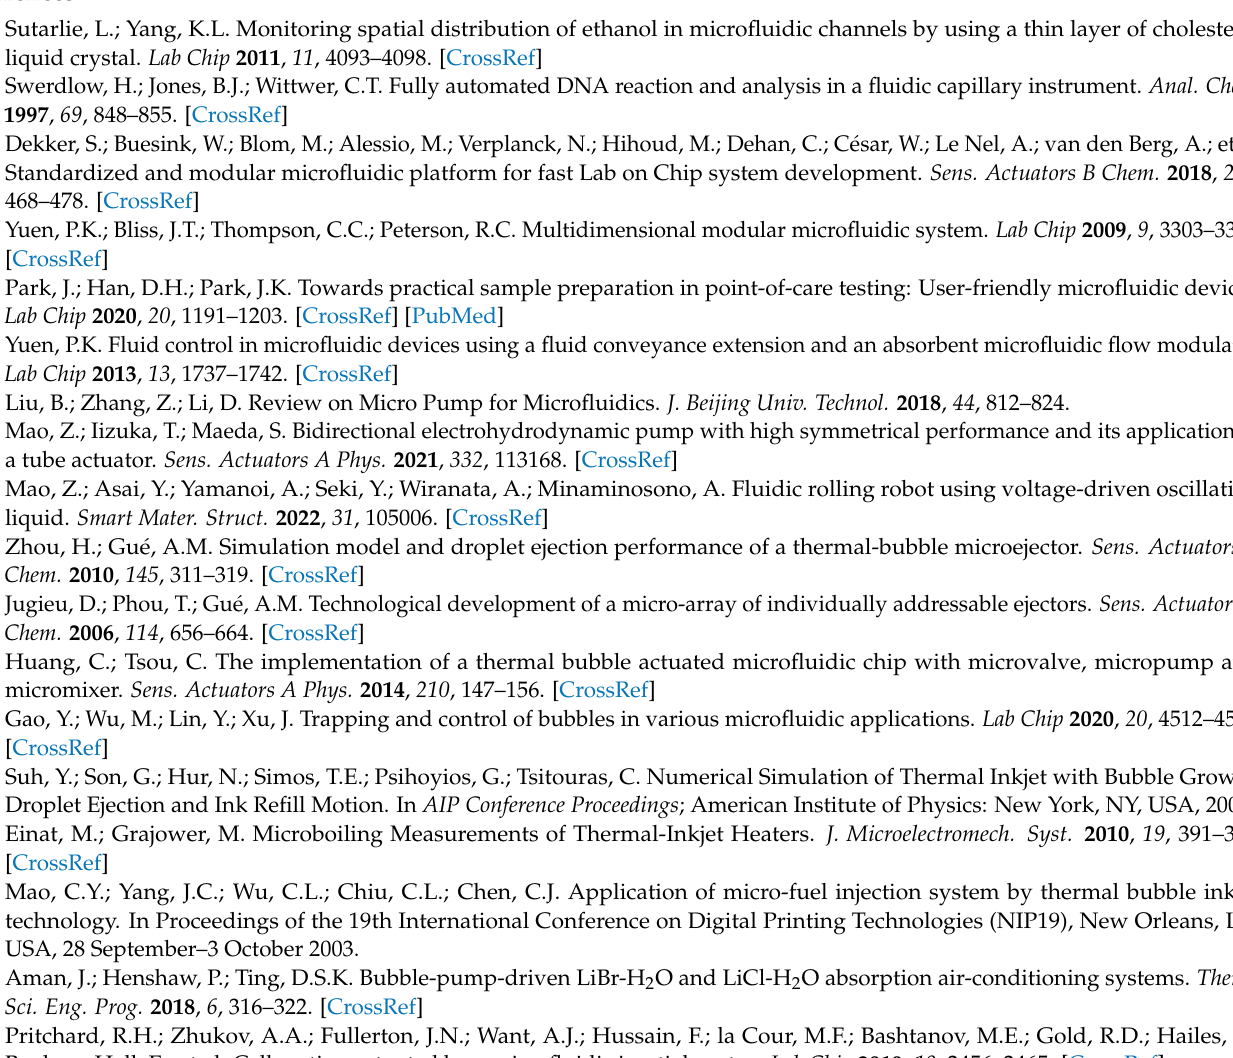
Figure S5: Different ways to control the temperature of the micropump. Figure S6. The linear relationship between temperature and voltage of thermometer. Video S1: Micropump